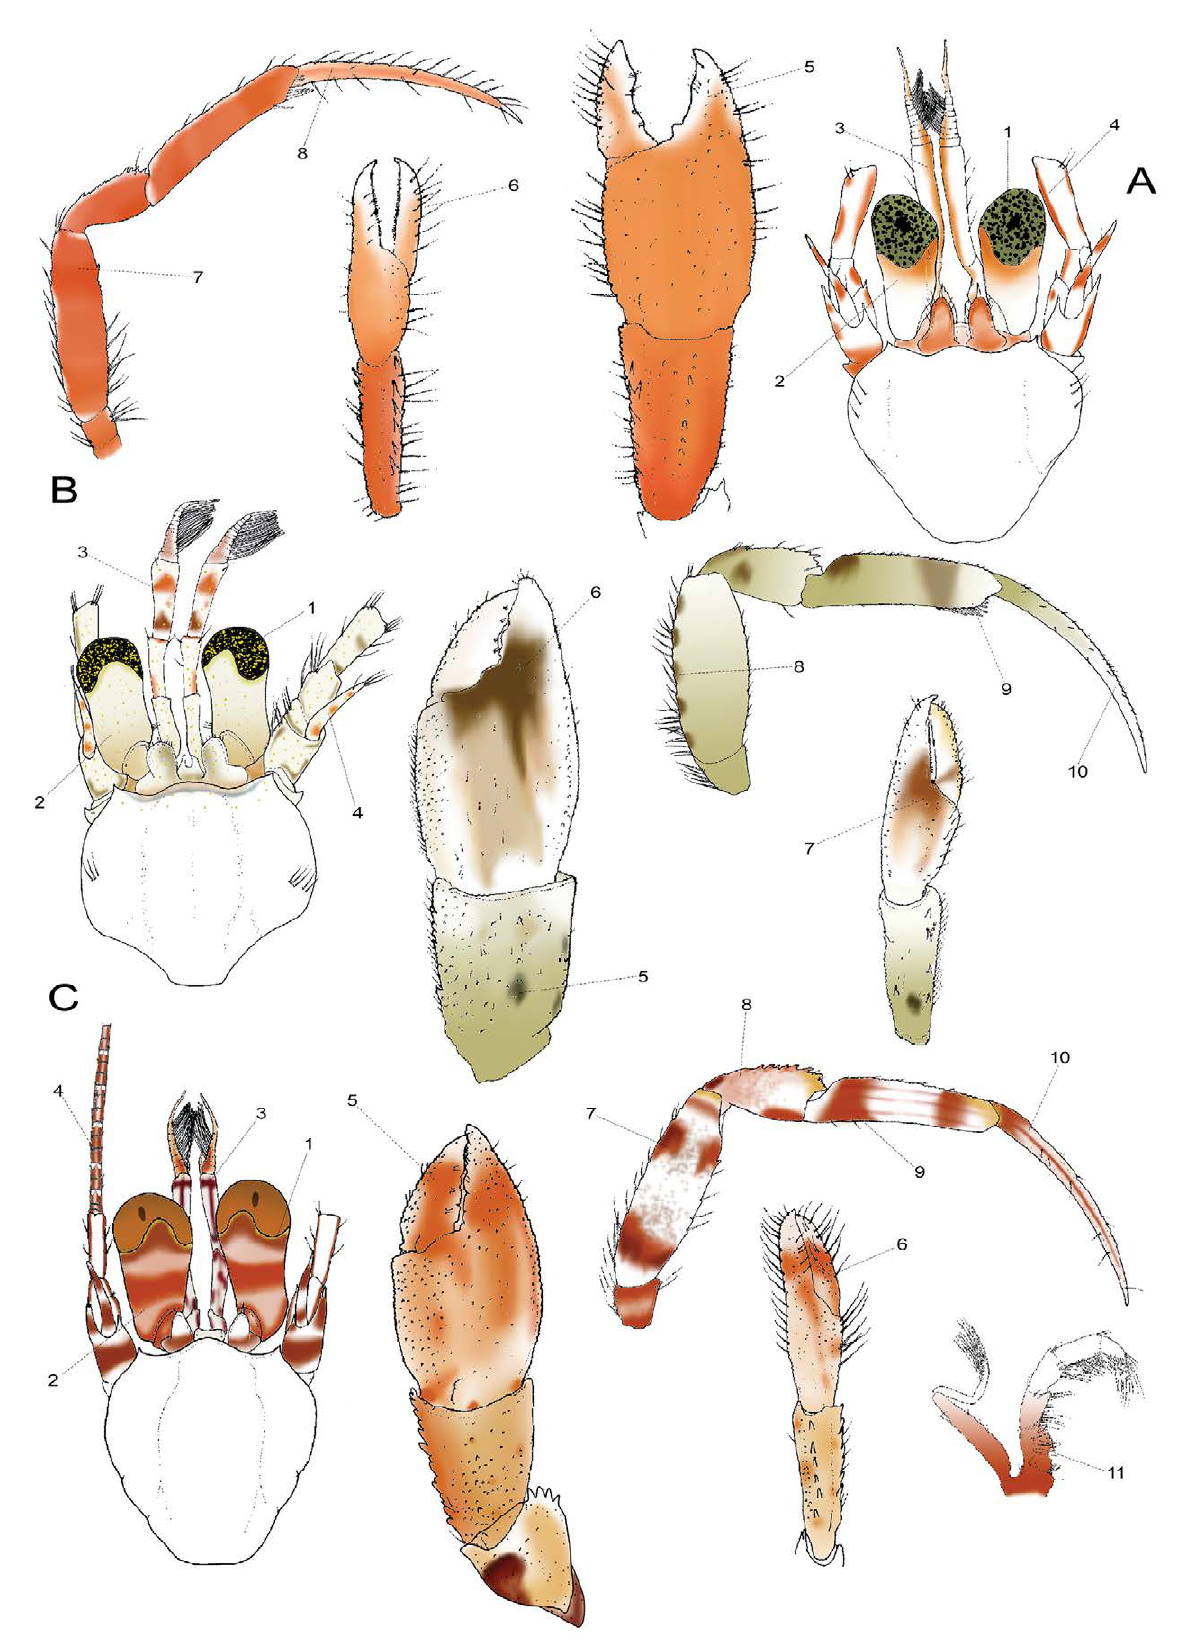
Fig. 6. – Colour patterns of Anapagurus species: A. longispina (A, 1-8); A. petiti (B, 1-10); A. pusillus (C, 1-11). All vectorial drawings modified from Ingle